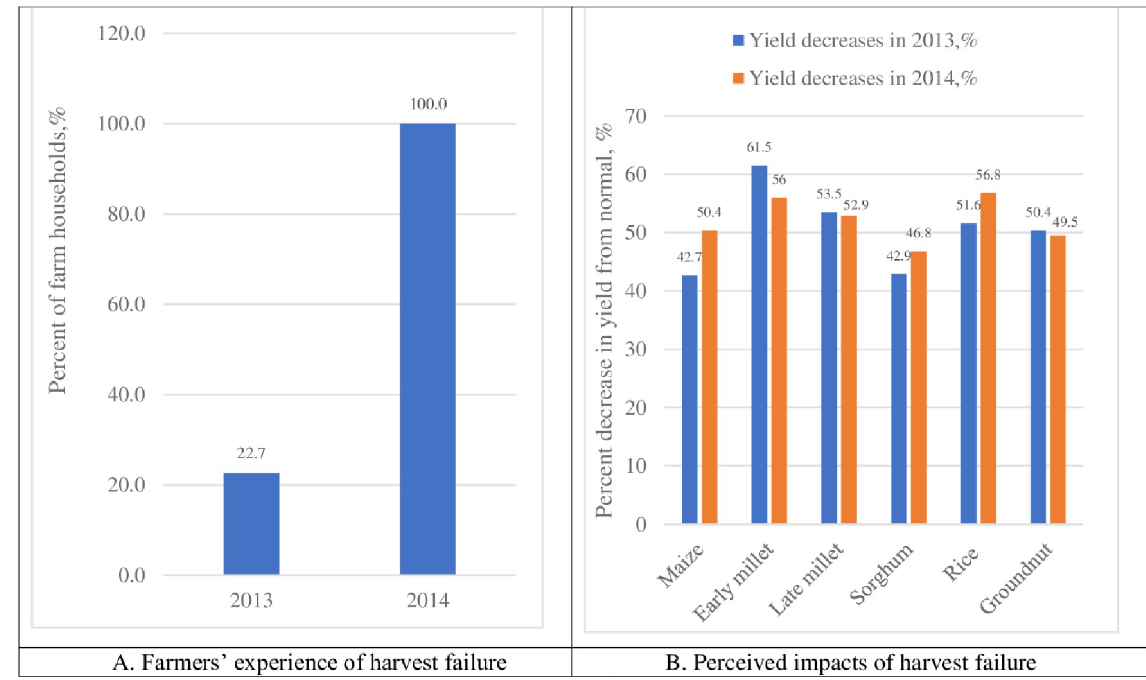
Fig 3. Farmers’ experience of harvest failure and perceived impacts. Source: Authors’ construct (based on household survey data).